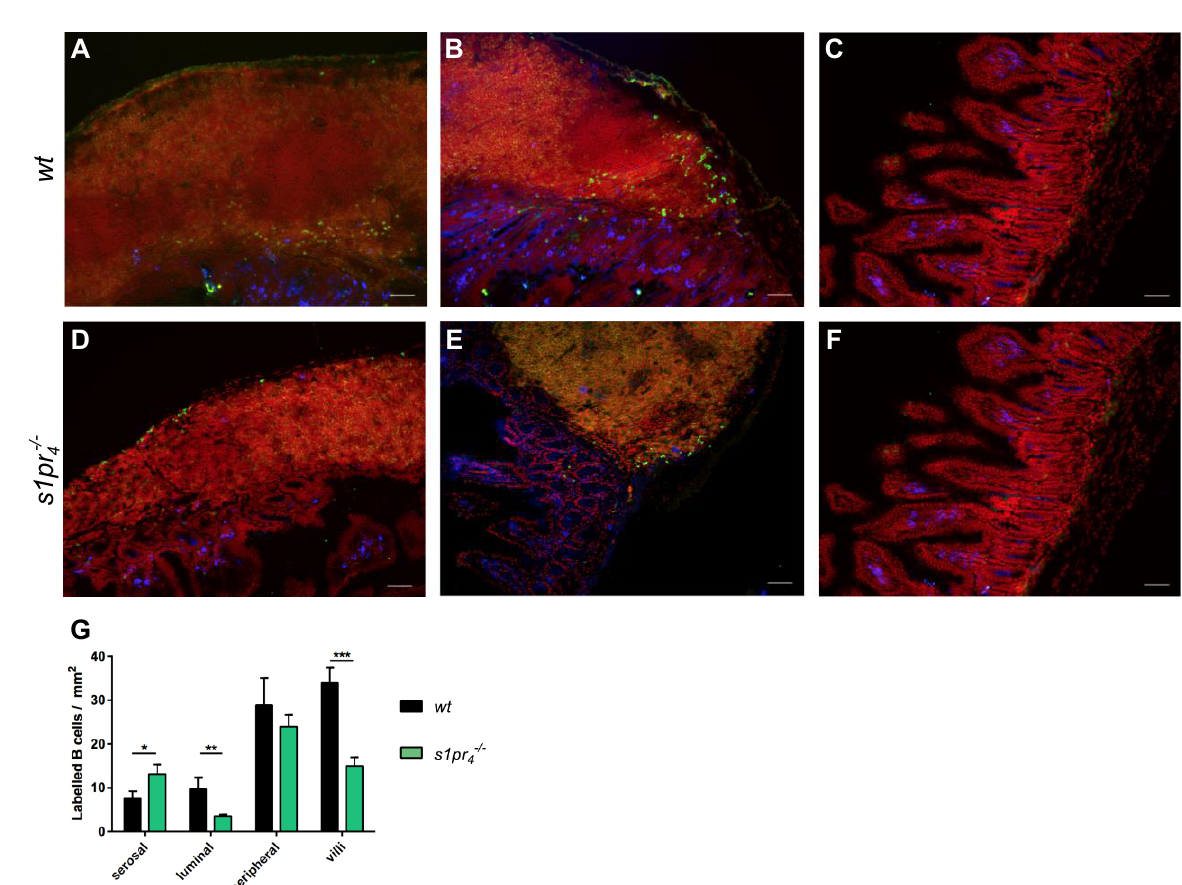
Figure 5. Localization of intraperitoneal transferred peritoneal B cells within Peyer’s patches after LPS stimulation in vivo. The signal intensity of CFSE from labeled cells was enhanced using polyclonal anti-FITC-Alexa488 (green). Tissue sections were additionally stained with anti-B220 (yellow) and anti-IgA (blue), while nuclei were stained with Draq5 (red) (white scale bar equals 50 µ m). Transferred B cells were identified as B220 + CFSE + . While wt B cells resided on the luminal side ( A ) of the PPs below the SED, s1pr 4 − / − cells were found on the serosal side ( D ) of the PP. At the outer edge of the PPs, B cells of both genotypes were found in large numbers ( wt : ( B ); s1pr 4 − / − : ( E )). There were significantly more wt ( C ) than s1pr 4 − / − ( F ) B cells within the intestinal villi. The vast majority of transferred B cells in the small intestine were IgA-negative. ( G ) The number of transferred B cells within the compartments of PPs was quantified using QuPath for the downstream segmentation and classification of cells. * p < 0.05, ** p < 0.01, *** p < 0.001.